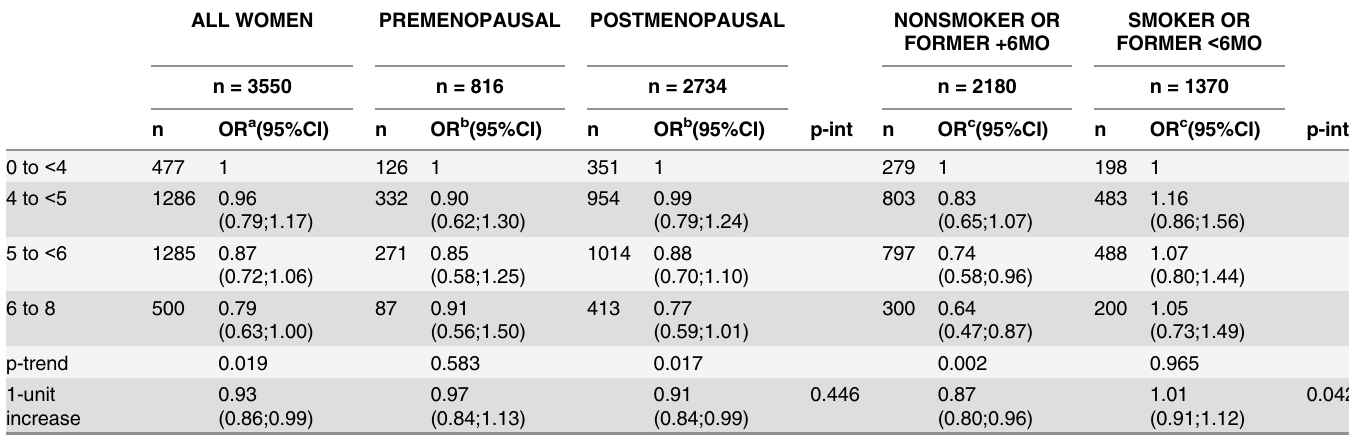
Table 3. Association between the WCRF/AICR score and MD in all women, by menopausal status and by smoking habit. ALL